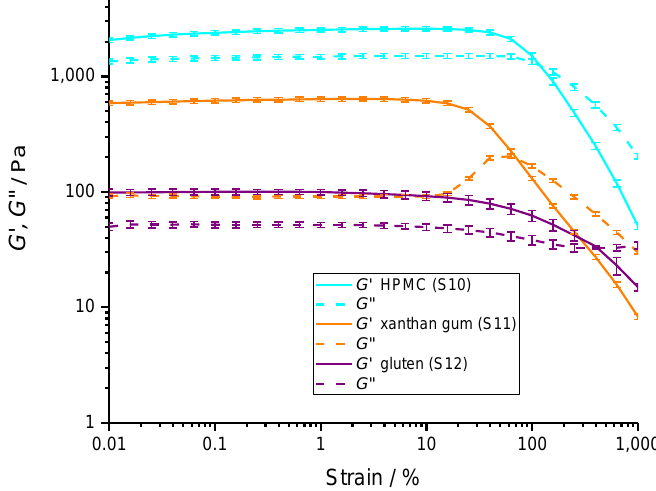
Figure 6. Rheology: Oscillatory amplitude tests performed on samples of individual hydrocolloids aqueous solutions. Storage ( G ′ , -----) and loss modulus ( G ″ , - - - -) of 8% xanthan gum in water (orange line, S11), 8% HPMC in water (blue line, S10) and 8% gluten in water (purple line, S12). The lines represent averages of three independent experiments ( n = 3) and the error bars correspond to SD. All concentrations are given as ( w / w ).